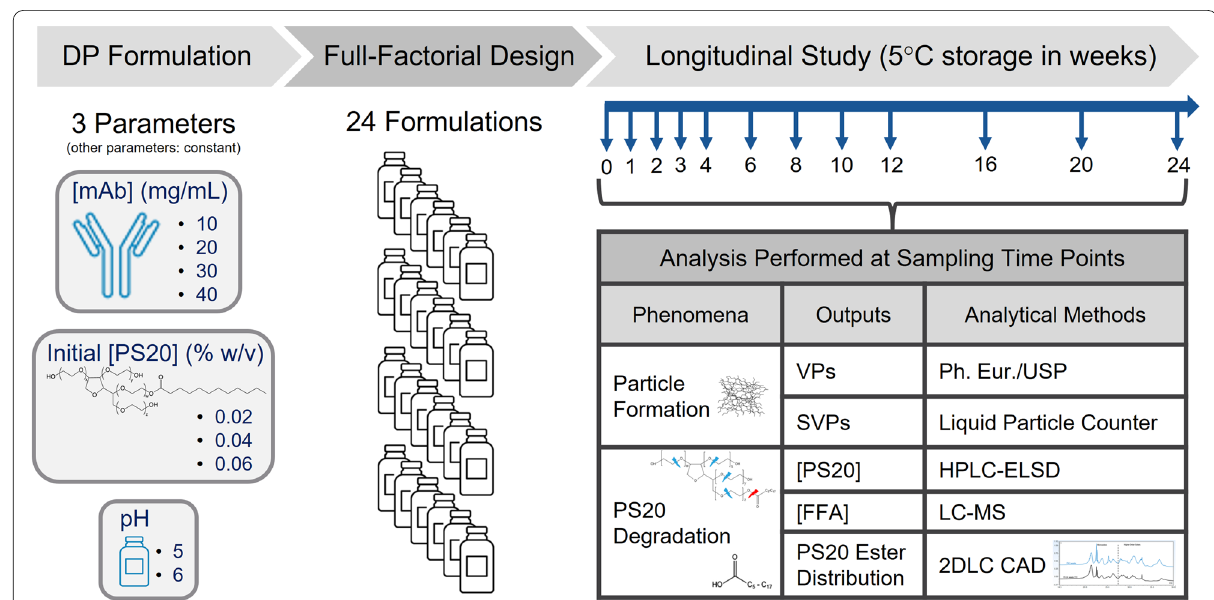
Fig. 1 DP stability study design to assess the impact of three formulation parameters on particle formation and PS20 degradation. The 24 DP formulations of mAb X—differing in [mAb], initial [PS20], and pH—were stored in glass vials at 5 °C and monitored using complementary/ orthogonal analytical methods for particle formation and PS20 degradation over 24